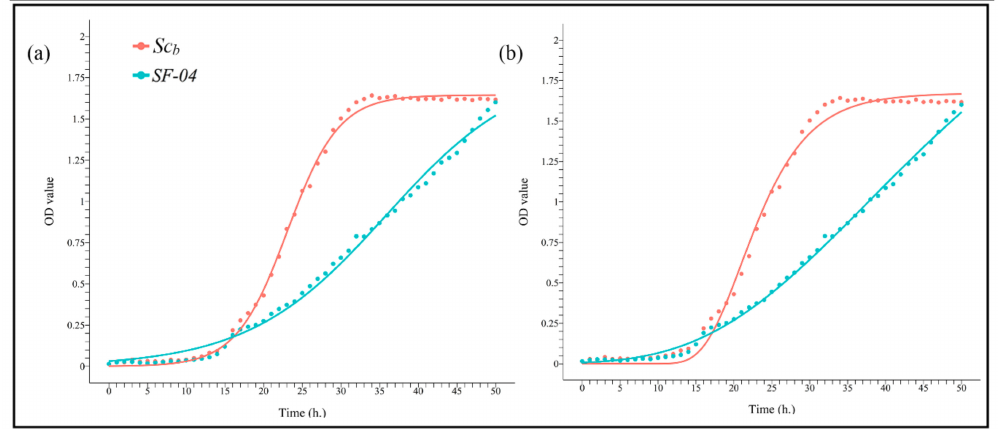
Figure 3. Experimental values (points) and mathematical modelling (continuous lines) of absorbance measurementsat630nmasafunctionoftimeforthe Saccharomycescerevisiae (SF-04)and Saccharomycescerevisiae var. boulardıi ( S Cb ) strains cultured in batch bioreactor in anaerobic conditions at 24 ± 1 ◦ C. Mathematical modelling was performed with the logistic ( a ) and Gompertz ( b )